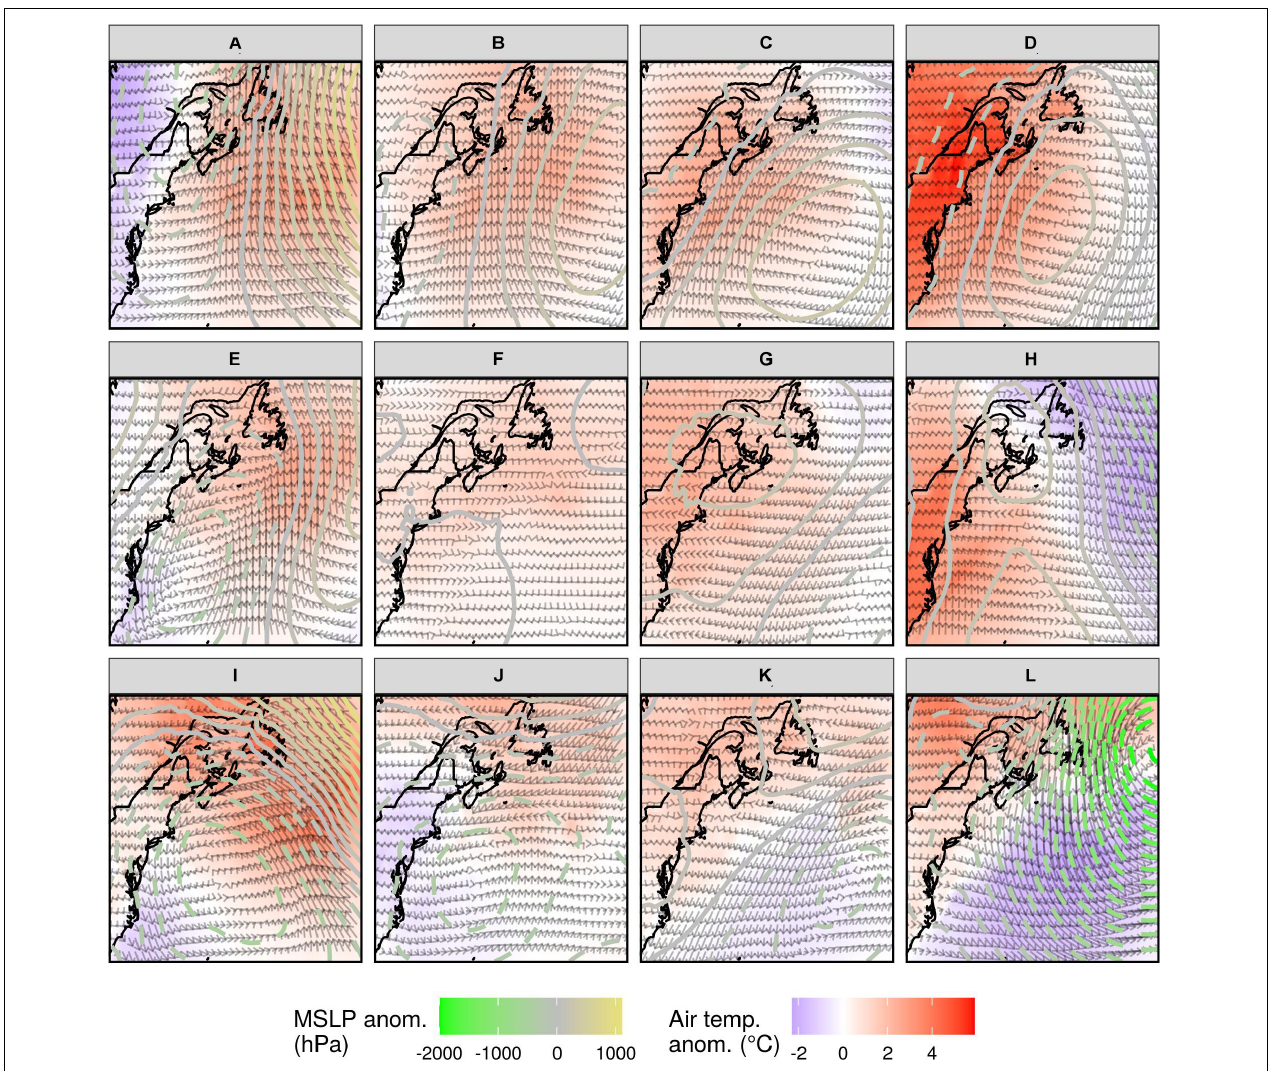
FIGURE 7 | The average synoptic states for anomalous air temperature, wind speed/direction (vectors), and MSLP (mean sea-level pressure) for each node in the SOM results (A–L) . Solid contours show positive MSLP anomaly and dashed contours show negative MSLP anomaly. The background colors of red to blue indicate air temperature anomaly. Note that MSLP was not one of the variables fed to the SOM, but is shown here to better outline the patterns in the wind and air